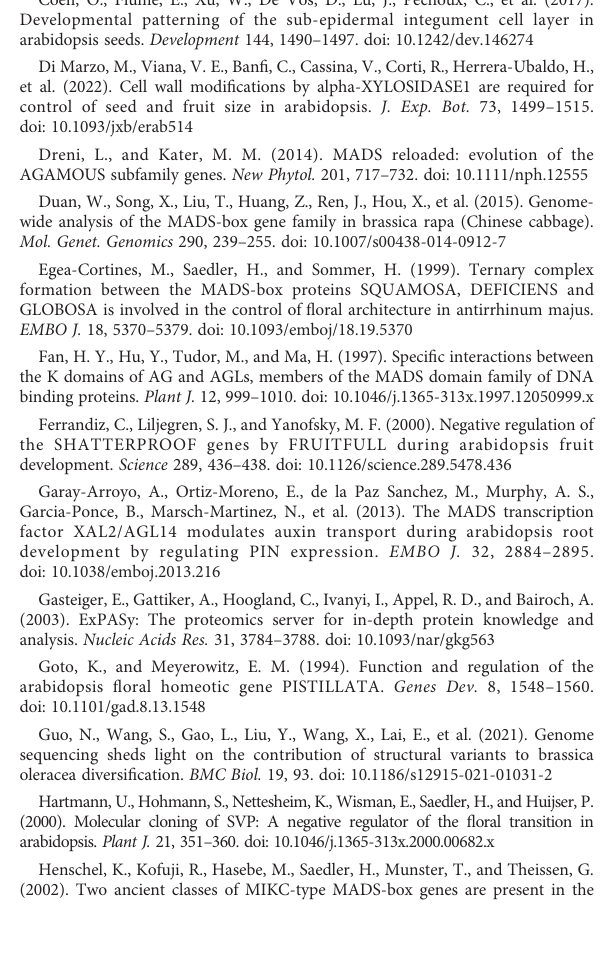
SUPPLEMENTARY FIGURE 2 Editing ef fi ciency of sgRNA-1 and sgRNA-2. SUPPLEMENTARY FIGURE 3 Multiple sequence alignment of BnaAG.A01 in WT and feml